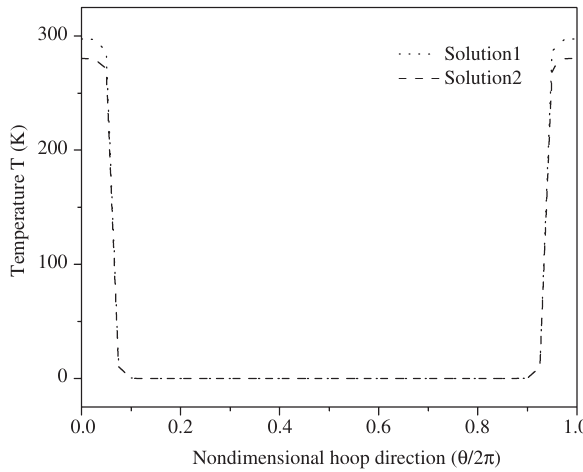
Figure 16 Distributions of temperature along the hoop direction of the FGM hollow cylinder, where t = 20 s.